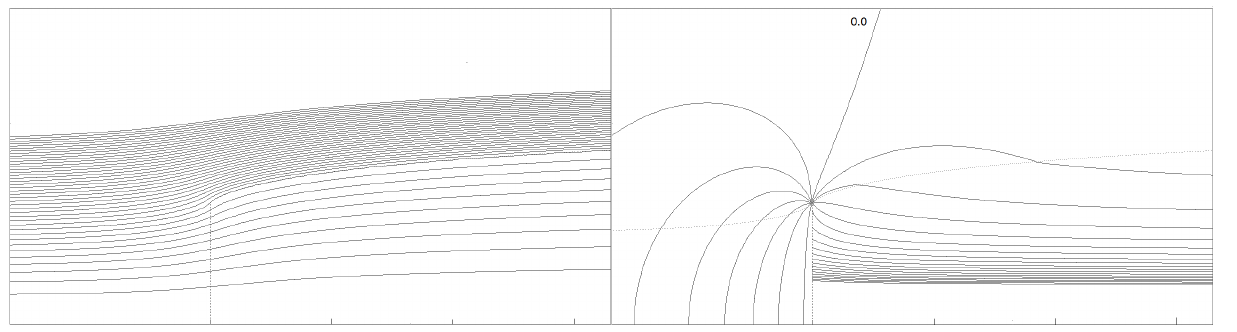
Figure 2. Streamlines with (cid:49)ψ = 0 . 1 (cid:49)ψ wake and isobars with (cid:49)p = 0 . 1 (cid:49)H for (cid:49)H/ ( 1 the wake axis are not plotted. Ticks at the axes are at a 1 R interval.